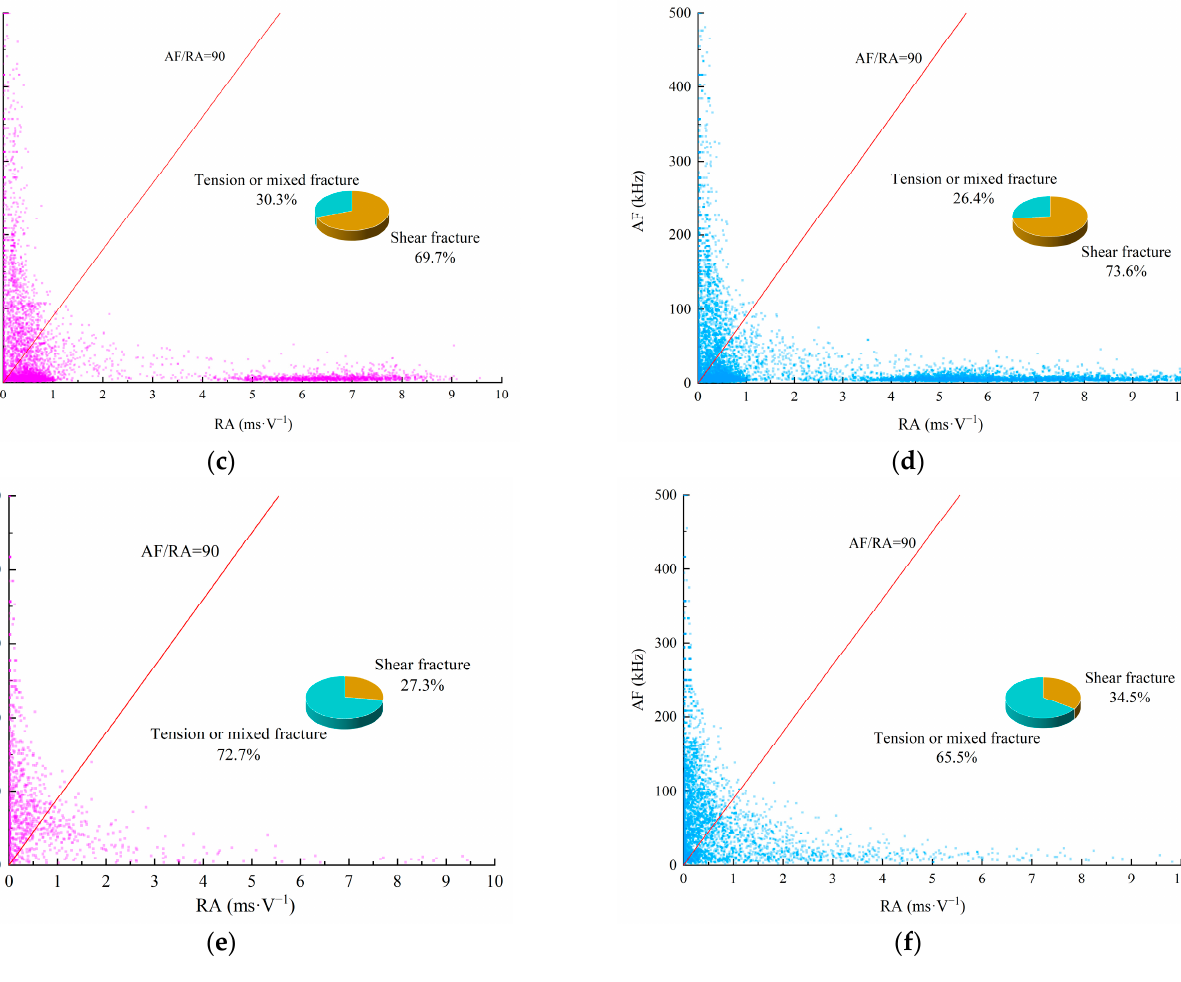
Figure 11. The change process of fracture mode at different stages under dynamic normal load. ( a ) Elastic stage under 10 kN. ( b ) Unstable development fracture stage under 10 kN. ( c ) Elastic stage under 30 kN. ( d ) Unstable development fracture stage under 30 kN. ( e ) Elastic stage under 50 kN. ( f ) Unstable development fracture stage under 50 kN.